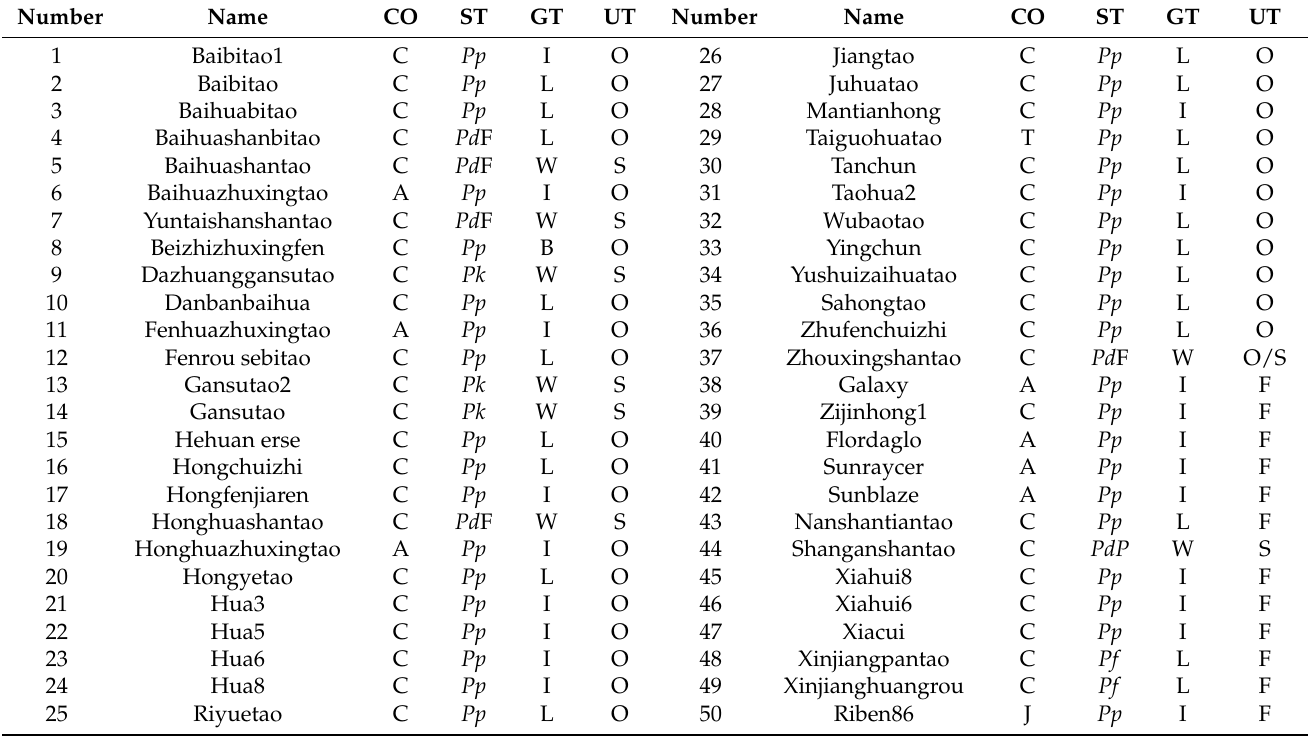
Table 1. Basic information about the tested peach